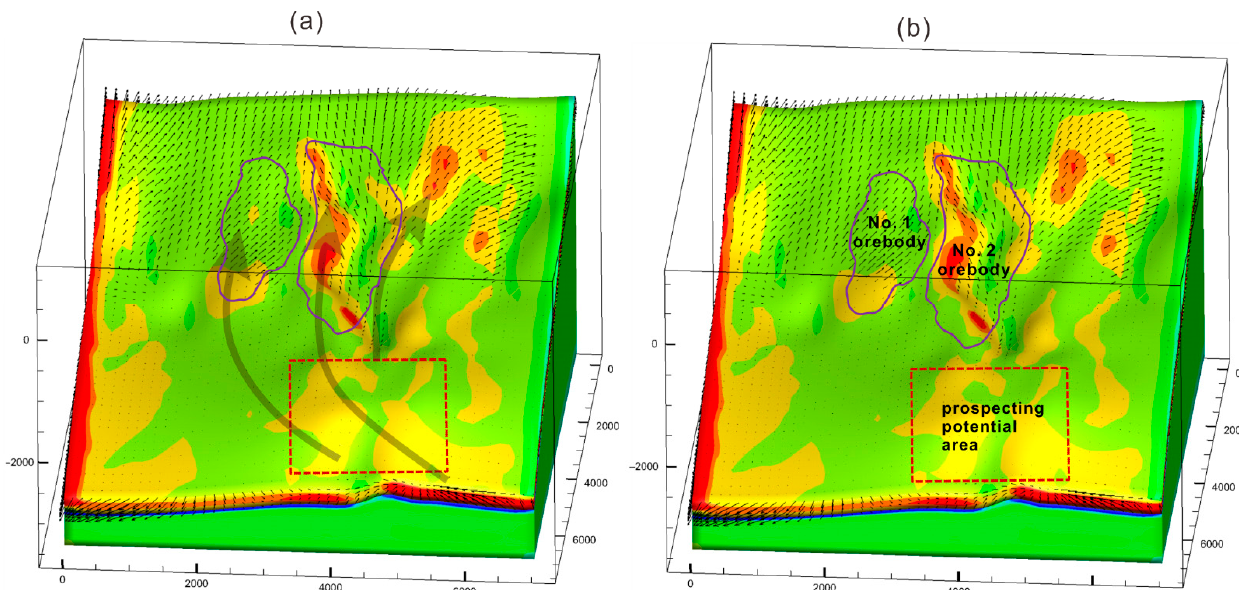
Figure 13. ( a ) Fluid migration model and ( b ) deep potential prospecting area at